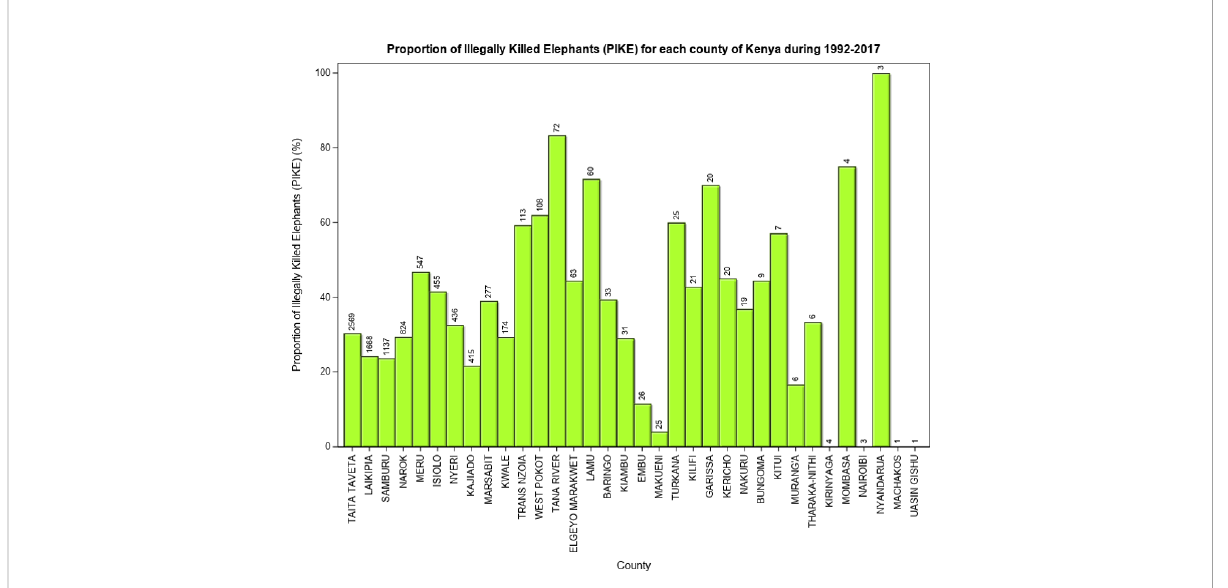
FIGURE 8 Proportion of Illegally Killed Elephants (PIKE) in 34 counties of Kenya during 1992-2017. The bar data labels are the total mortalities recorded for each county during